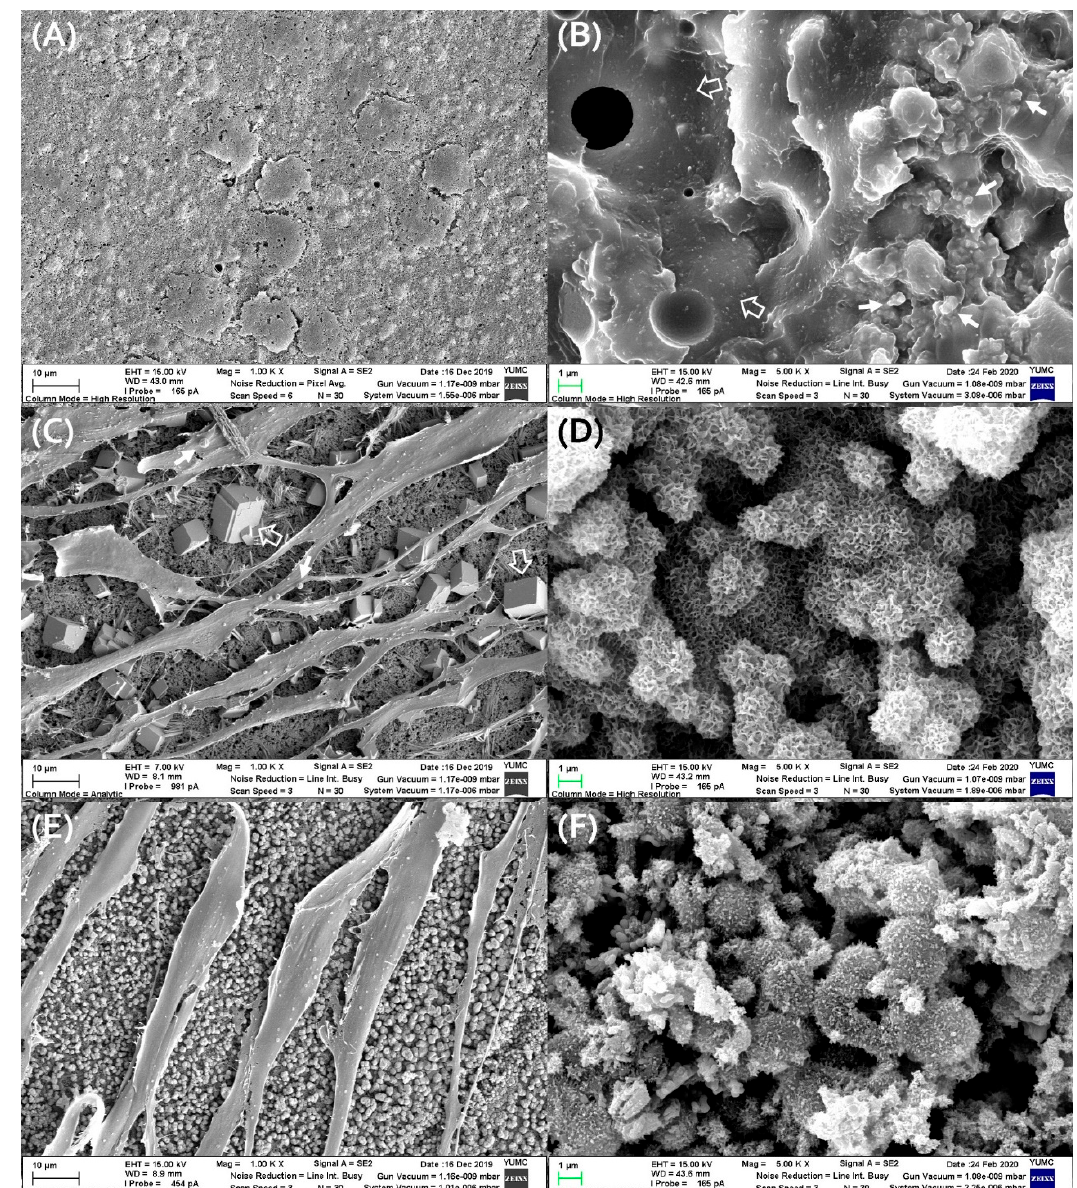
Figure 6. Cell attachment of hPDLSCs on the set material disc and surface of set material disc. Cell attachment ( A , C , E ) is shown at magnification of 1000× and material surface morphology ( B , D , F ) is shown at magnification of 5000×. ( A ) Cell attachment and morphology on the set AH-Plus. ( B ) Surface morphology of the set AH-Plus; AH-Plus showed resinous matrix (open arrow) and fine filler particles (closed arrow). ( C ) Cell attachment and morphology on the set CeraSeal; Well-adhered hPDLSCs with production of globular extracellular matrix (closed arrow) were shown and characteristic cubic particles (open arrow) can be identified. ( D ) Surface morphology of the set CeraSeal; Honeycomb morphology or acicular spherule morphology is observed. ( E ) Cell attachment and morphology on the set EndoSeal TCS; High degree of cell proliferation and well-adhered hPDLSCs were shown. ( F ) Surface morphology of the set EndoSeal TCS; Typical acicular spherule crystals are observed.